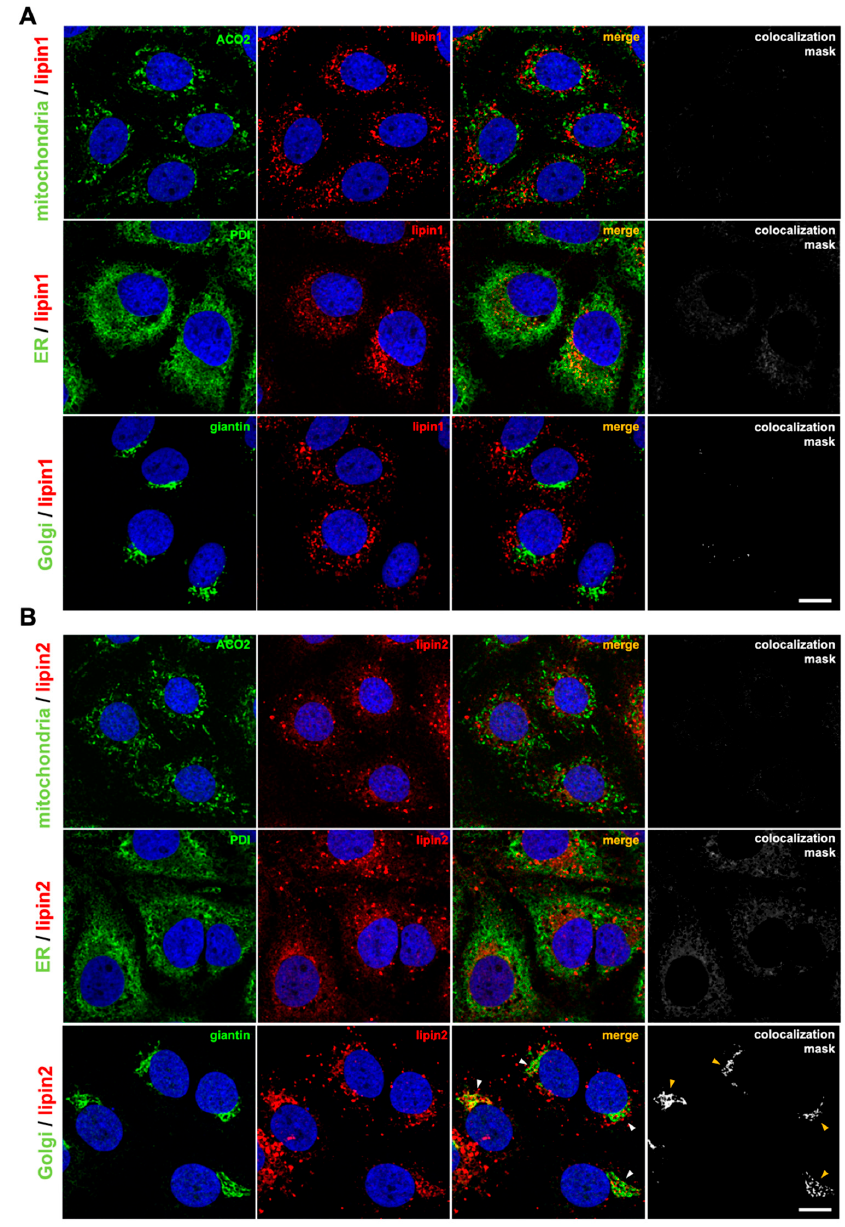
Figure 4. Lipin2 partially overlaps with subcellular Golgi distribution. Huh-7 cells were fixed with 4% formaldehyde and permeabilized using TX 100 as described in Materials and Methods. Subcellular localization of ( A ) lipin1 (in red) or ( B ) lipin2 (in red) was analyzed by colocalization analysis with markers (in green) of ER (PDI), mitochondria (ACO2) or Golgi (giantin) by immunofluorescence confocal microscopy. Representative images show lipin1 or lipin2 (red) with the different organelle markers (green). Nuclei were stained with DAPI and are shown in blue. Colocalization masks were generated using Fiji software. Scale bar 20